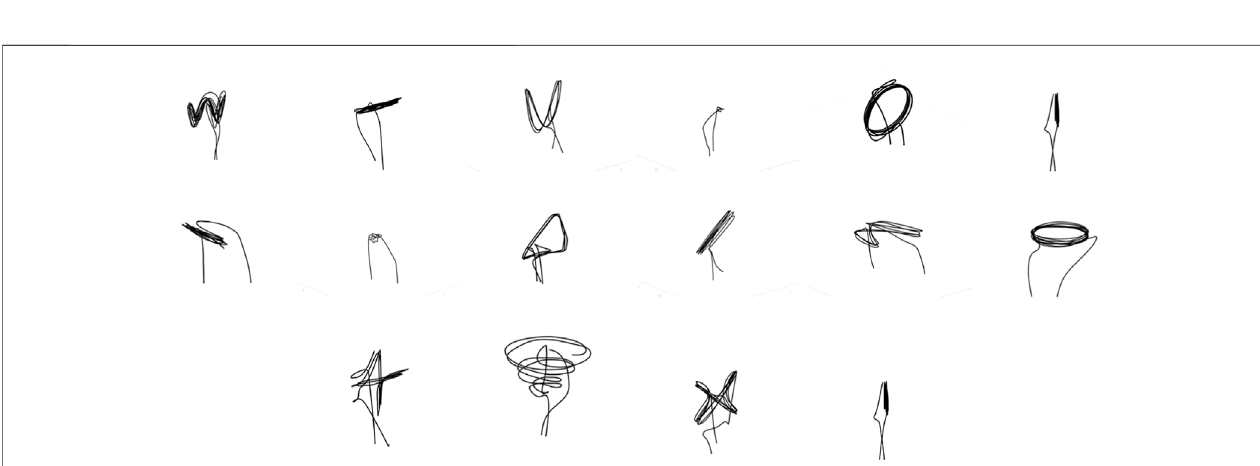
FIGURE 2 | Flight paths from top left to bottom right: undulate, left-right, U-shape, hover, vertical circle, up-down/descend, front-back, yaw, descend and shift, diagonal descend, horizontal fi gure 8, horizontal circle, plus, spiral, X-Shape, and up-down.